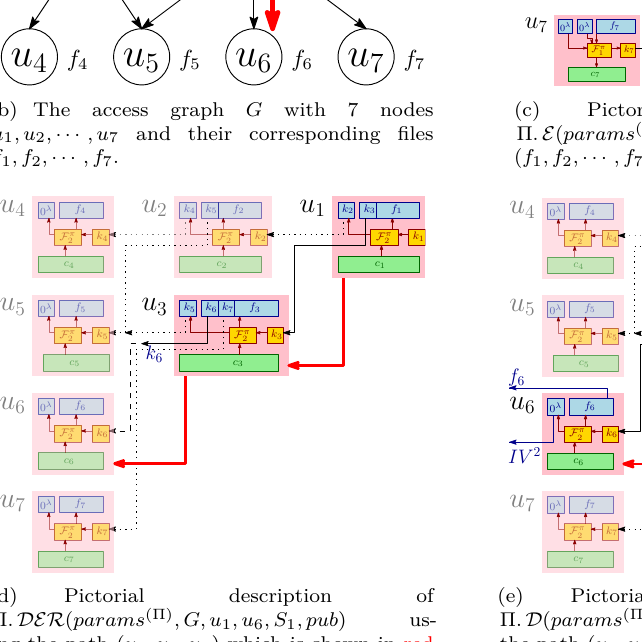
Pictorial description of Π . E ( params (Π) ,G,f ), where f = ( f 1 ,f 2 , ··· ,f 7 ) and G is shown in 21(b).